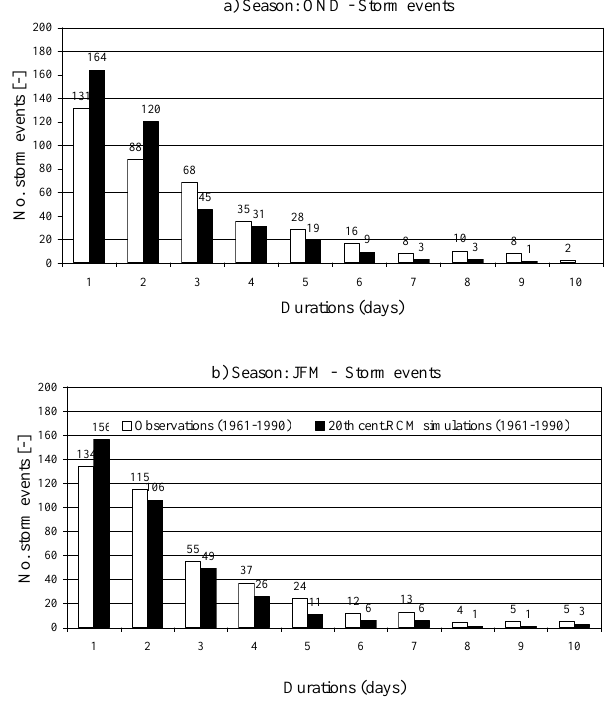
Fig. 5. Storm events (relative to cell #4) ranked according to their durations, coming from the observations and RCM simulated pre- cipitation for the period 1961–1990: (a) autumn season; (b) winter